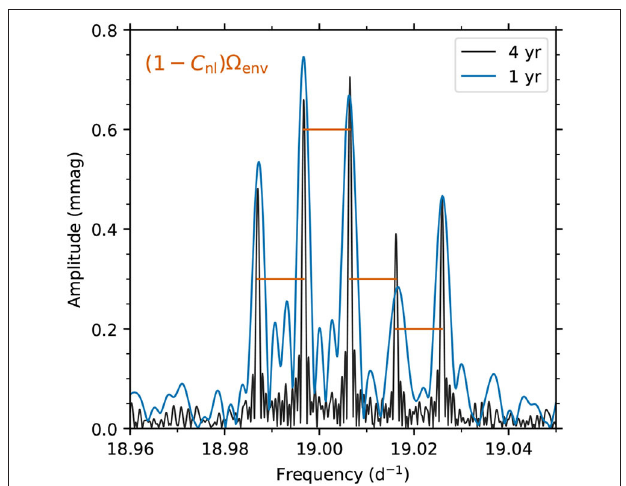
FIGURE 1 | Example of rotational splitting of quadrupole p modes into a quintuplet using both 1 and 4-years light curves of the star KIC 11145123 (Kurtz et al., 2014). Horizontal red lines correspond to the rotational splitting value of the